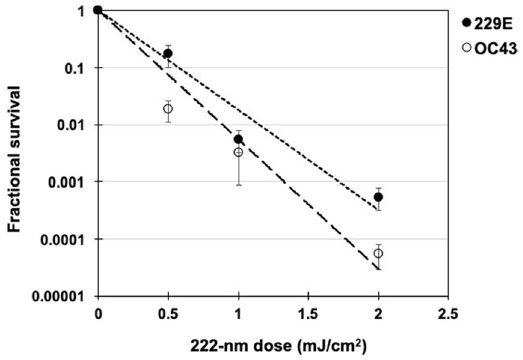
Figure 1. Coronavirus survival as function of the dose of far-UVC light. Fractional survival, PFU UV / PFU controls, is plotted as a function of the 222-nm far-UVC dose. The results are reported as the estimate plaque forming units (PFU)/ml using the conversion PFU/ml = 0.7 TCID 5029 by applying the Poisson distribution. Values are reported as mean ± SEM from multiple experiments (n = 3 alpha HCoV-229E and n = 4 for beta HCoV-OC43); the lines represent the best-fit regressions to equation (1) (see text and Table